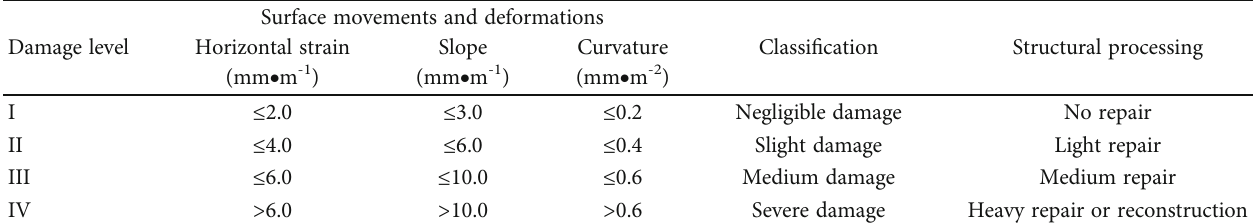
Table 1: Classi fi cation of critical deformation values of surface concrete structures [37].